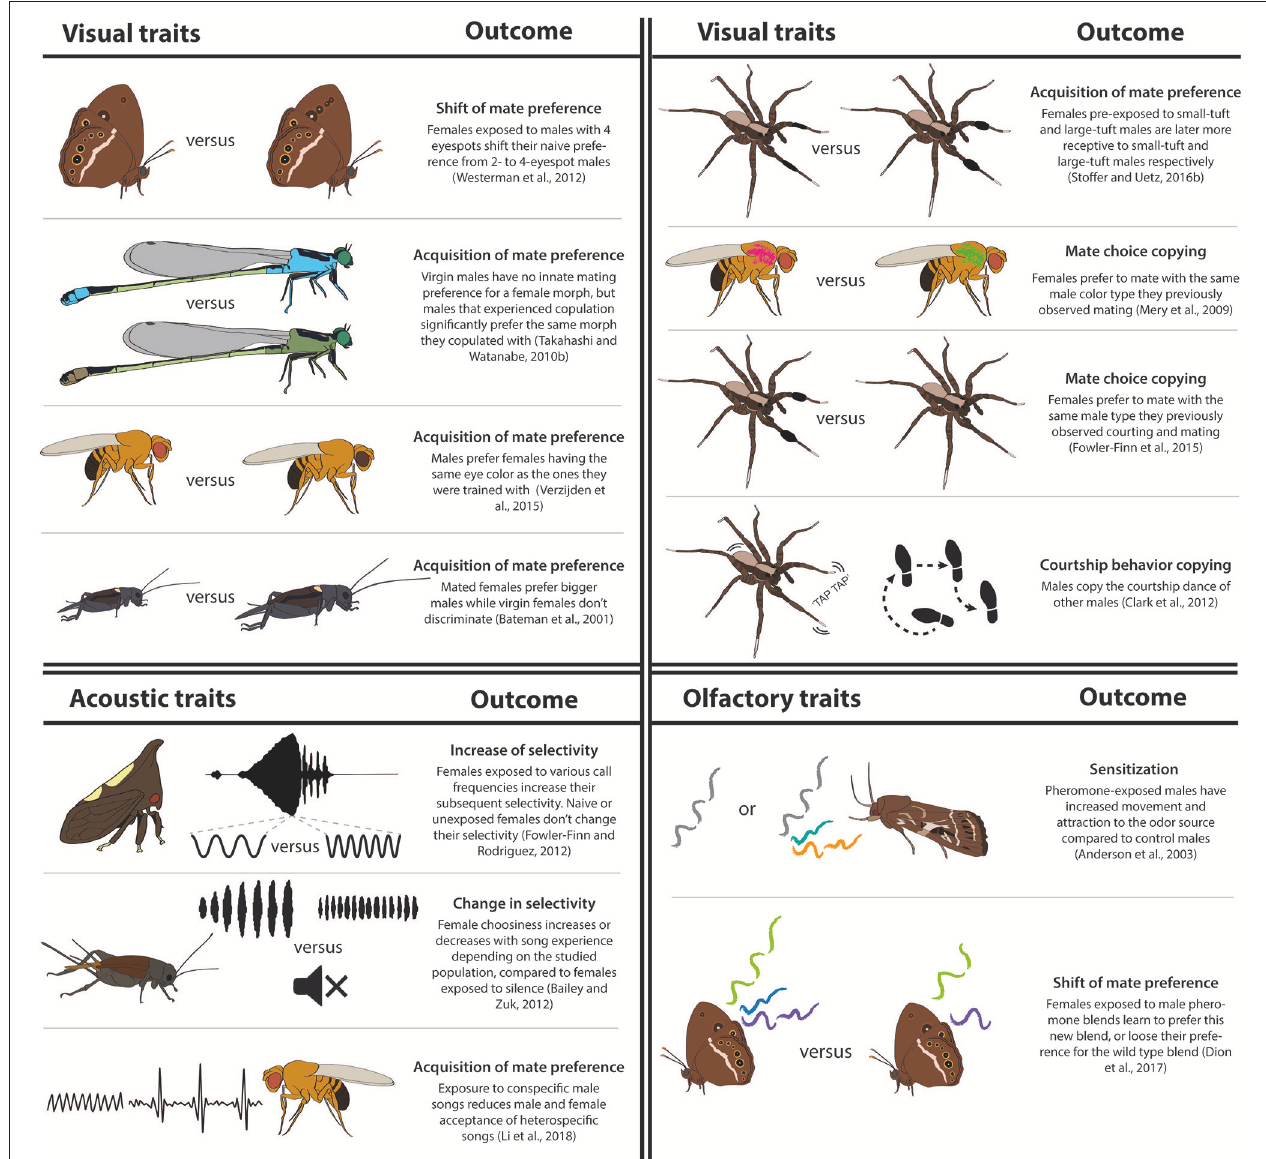
FIGURE 2 | Illustrations of learning sexual traits or preferences in insects and spiders. Learning can produce an acquisition or a shift of preference, or a change in the insect selectivity for the sexual signal. These processes can be due to mate choice or sexual signaling copying or to sensitization, which is an increase of the individual attraction to the stimuli upon exposure. All examples illustrate changes in the mate preference function, except for the courtship behavior copying, which illustrates a change in sexual